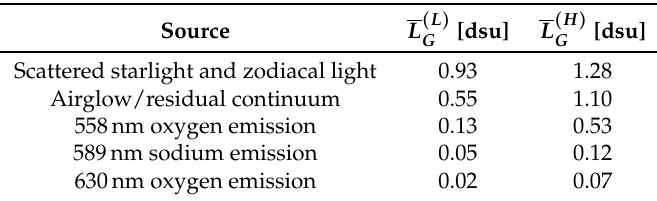
Figure 2. Samples of the used light source spectrum database to fit night time spectra. CFL: compact fluorescent lamp; HPS: high pressure sodium, LED-1: cold white LED; LED-2: warm white LED; LED3: phosphor converted amber LED. Table 1. Components of the natural sky